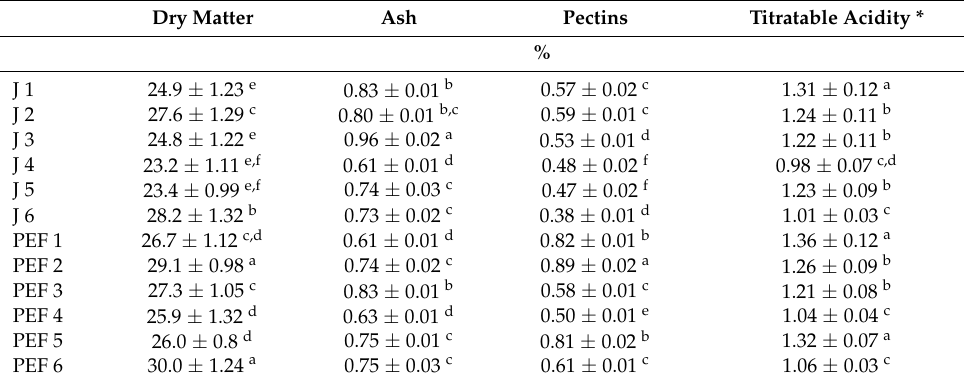
Table 1. Content of dry matter, ash, pectins, and acidity of chokeberry fresh juice and juice treated using